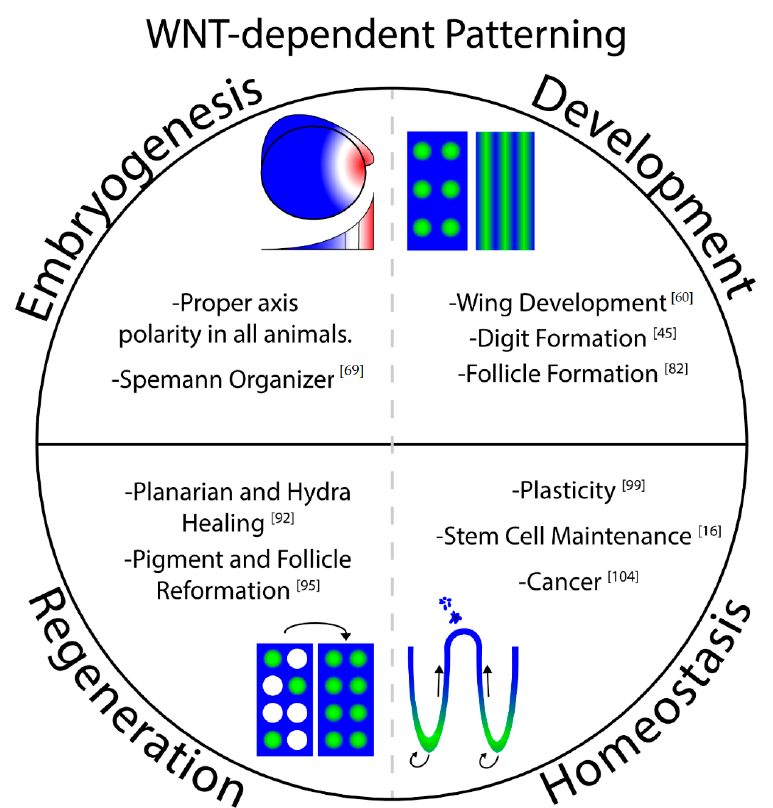
Figure 2. Wnt / β -catenin signaling in tissue self-organization. Two main categories are shown, Embryogenesis / Development (top) and Regeneration / Homeostasis (bottom). The categories were partitioned due to reversibility. Development of the embryo and body axis as well as appendage development are irreversible and temporally regulated patterning processes. Uniquely, regeneration and homeostasis are ongoing processes that an organism must call upon when needed. These processes have a greater need to be autonomous and could not withstand removal of a morphogen source unless there was a mechanism in place for sensing and replacing a missing